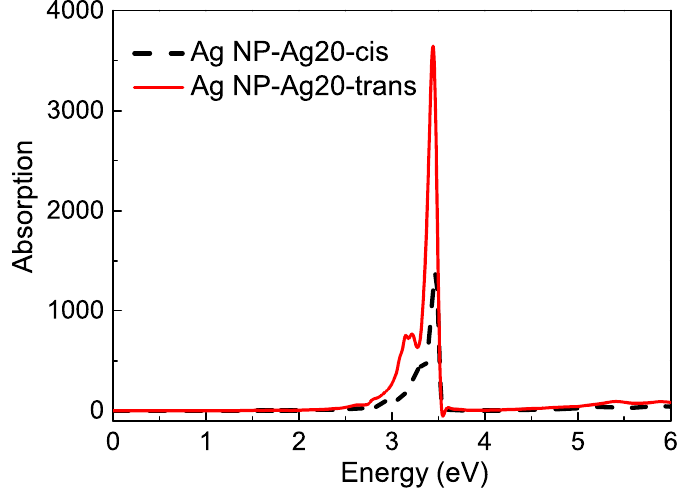
Figure 7. The surface-enhanced absorption spectra in model